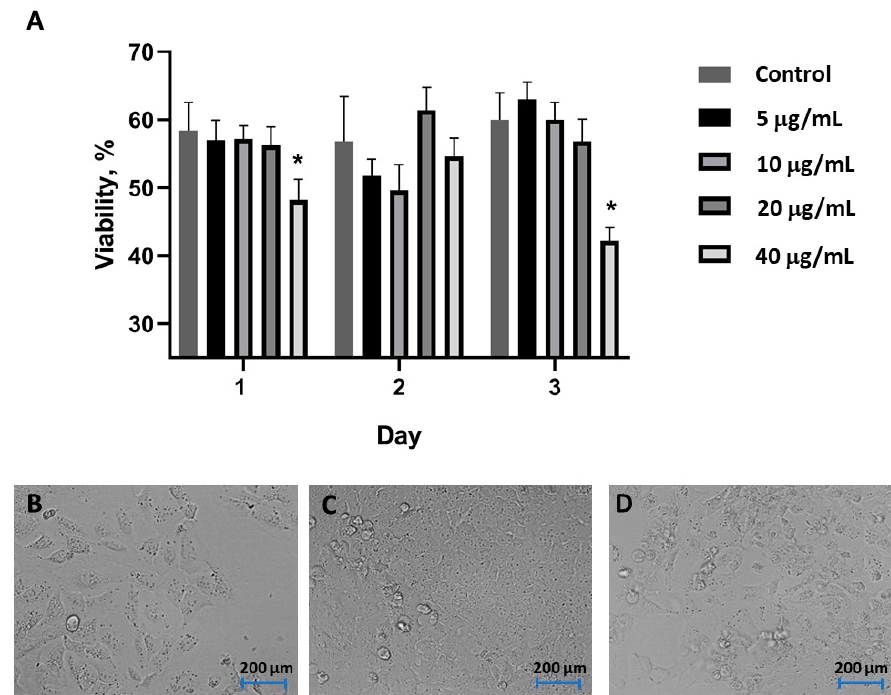
Figure 3. U2OS viability ( A ) evaluated by resazurin reduction assay for 3 days after the exposure to AgNAs at concentrations from 5 to 40 µ g/mL. ( B–D ) Cell morphology assessment on days 1, 2, and 3 after exposure to 20 µ g/mL AgNAs. *—significant differences between non-treated controls and AgNAs groups ( p ≤ 0.05).